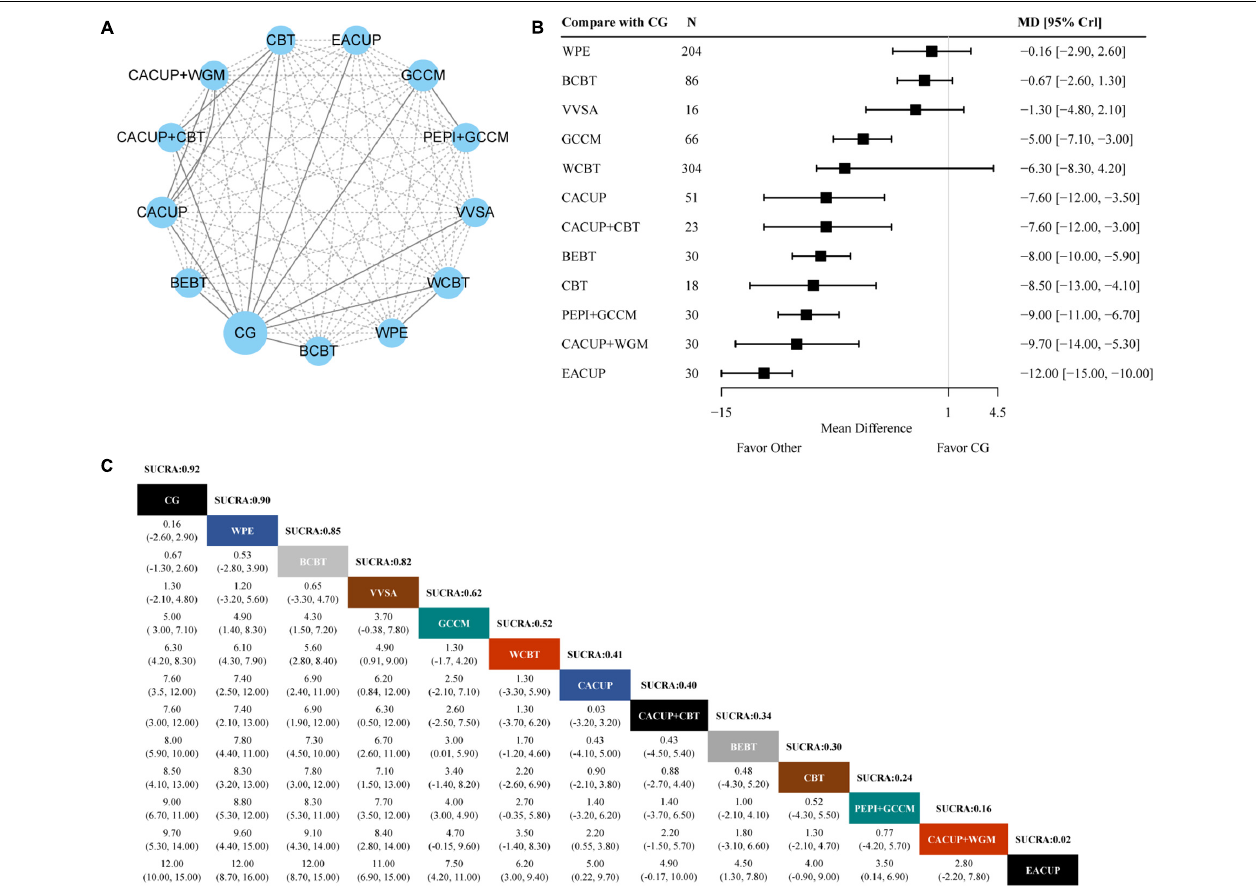
FIGURE 2 | Results of the network meta-analysis for CES-D. (A) Network geometry of eligible comparisons for CES-D. (B) Forest plot of the network meta-analysis compared with control group. (C) Ranking of each intervention based on the SUCRA values and the league table for the relative effects of all treatments. EACUP, electroacupuncture; CACUP, conventional acupuncture; WGM, wheat-grain moxibustion; GCCM, group counseling with Chinese medicine; CBT, cognitive behavioral treatment; BEBT, brain electrical biofeedback therapy; WCBT, web-based cognitive behavioral treatment; VVSA, video viewing smartphone application; BCBT, bibliotherapy-based cognitive behavioral treatment; WPE, web-based psycho education; CG, control group; SUCRA, surface under the cumulative ranking curve; MD, weighted mean difference; CrI, credible